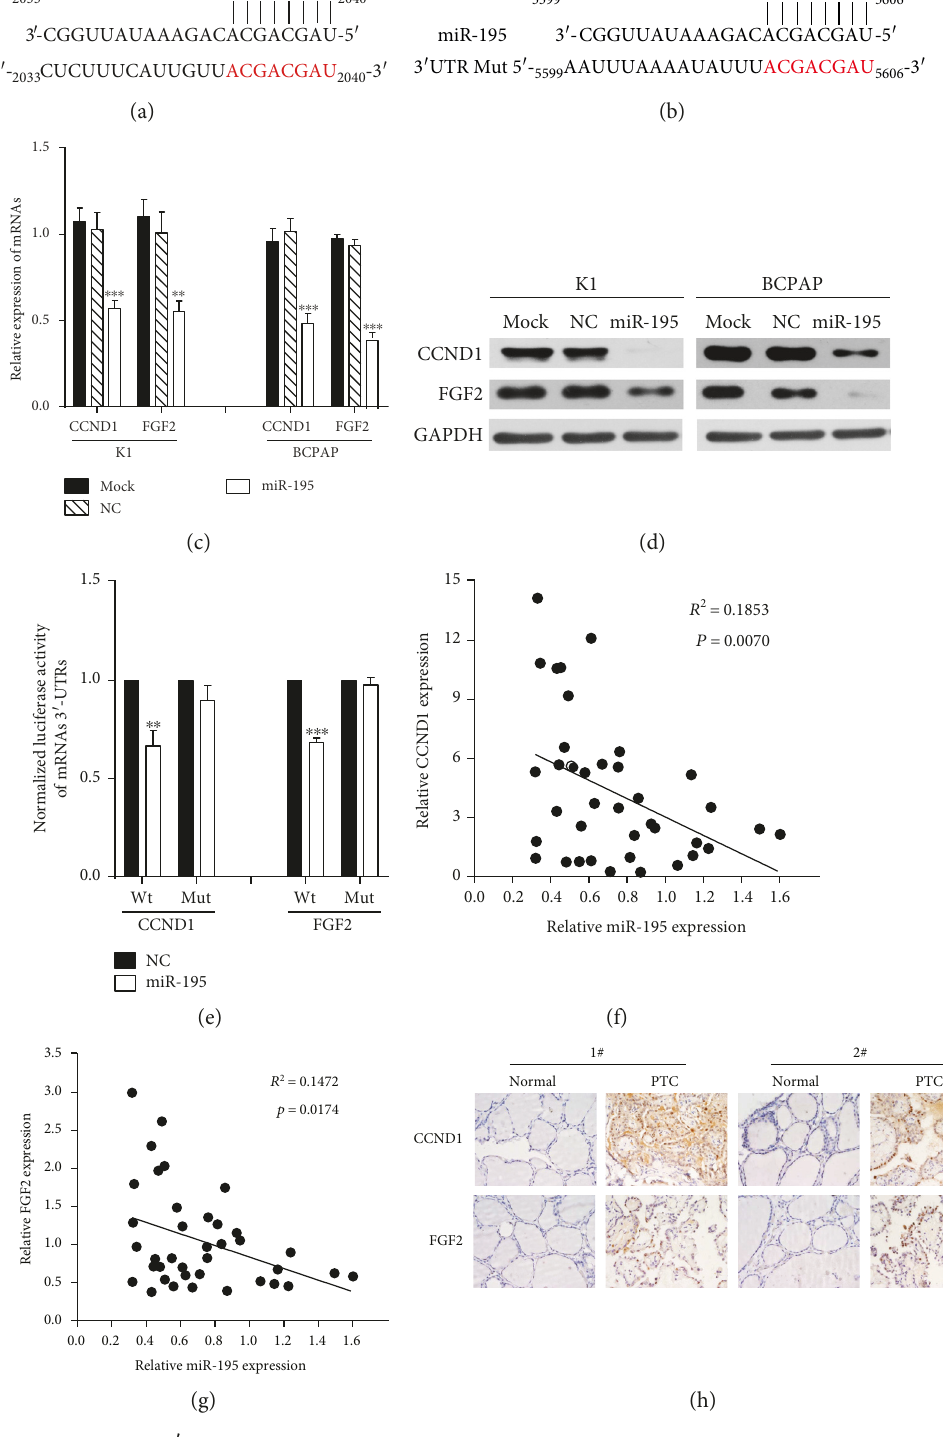
Figure 5: MiR-195 directly targets the 3 ′ -UTRs of CCND1 and FGF2 . (a, b) Predicted binding sites of miR-195 seed sequence and 3 ′ -UTRs of CCND1 and FGF2 . The sequences precisely modi fi ed were marked in red. (c) The relative mRNA expression of CCND1 and FGF2 in K1 and BCPAP cells 24 h after miR-195 transfection. (d) Protein levels of CCND1 and FGF2 48 h after miR-195 transfection. (e) Luciferase assays of CCND1 and FGF2 in 293T cell. (f, g) Signi fi cant inverse correlations were presented between miR-195 and CCND1 as well as FGF2 in human PTC tissues. (h) IHC detection of CCND1 and FGF2 proteins in normal thyroid and PTC tissues. Two representative examples are shown. Magni fi cation, 400x. ∗∗ P < 0 01 compared with the control group, ∗∗∗ P < 0 001 compared with the control